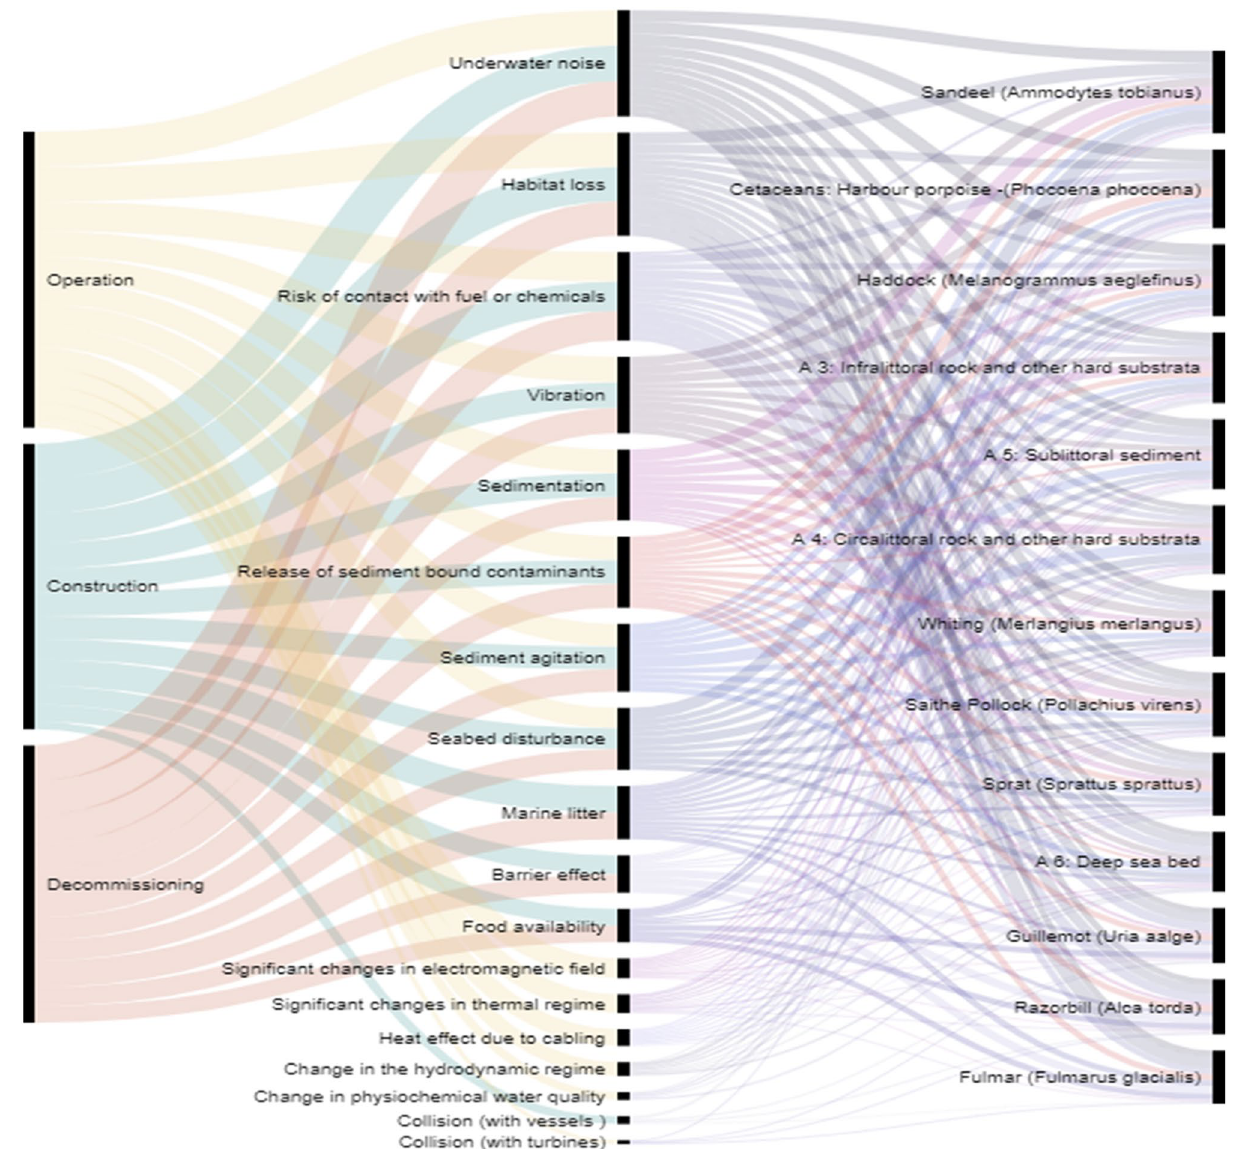
Figure 7. Impact chain defining OWF phases-pressure-environmental components analysed in the North Sea (the strength of the link between pressures and environmental components is proportional to the sensitivity scores. The order is descending from the pressures with highest impact, as well as from the environmental components most